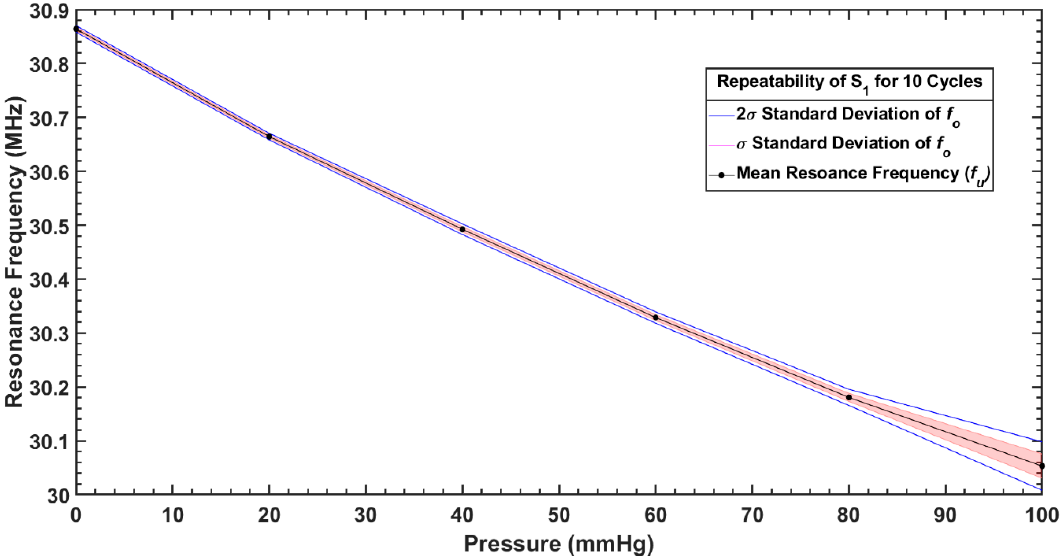
Figure 17. Repeatability of measurements with S 1 over 10 cycles.